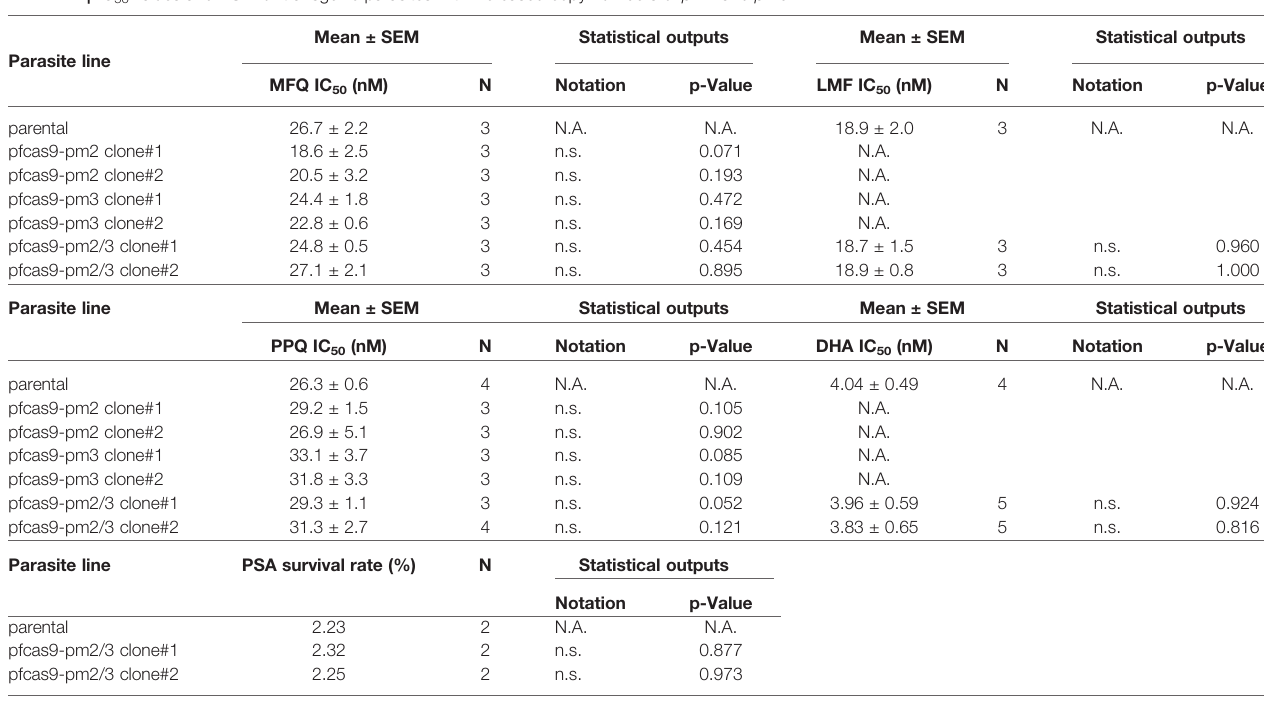
TABLE 2 | IC 50 values and PSA for transgenic parasites with increased copy numbers of pm2 and pm3 .